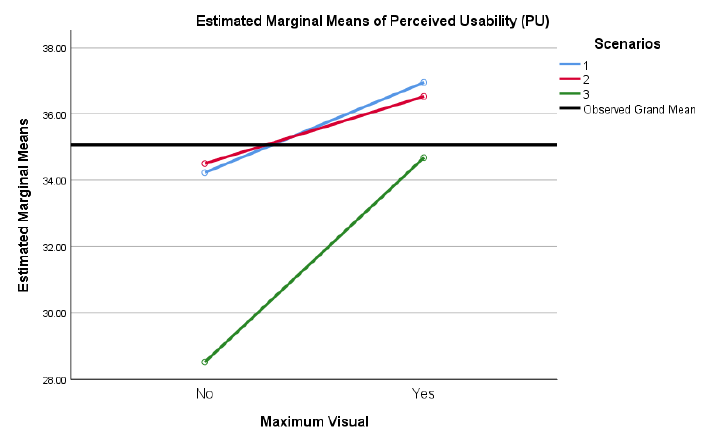
Figure 6. Estimated marginal means—PU.